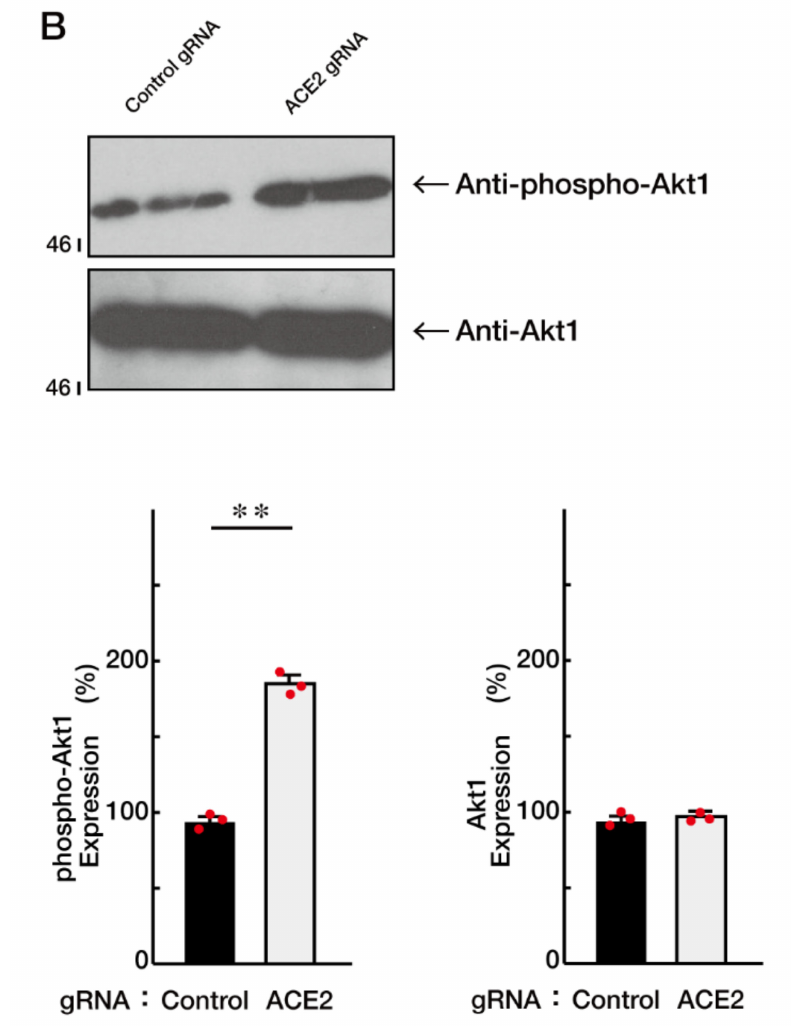
Figure 3. Knockdown of ACE2 promotes Akt1 phosphorylation whose site is essential for Akt1 activation. ( A ) The lysates of siRNA-knocked down FBD-102b cells were used for immunoblotting with an anti-phosphorylated (phospho) Akt1 or Akt1. These two different blots were performed from the same samples. Band intensities were also compared to be depicted in graphs (**, p < 0.01; n = 3 blots). ( B ) The lysates of gRNA-knocked down cells were used for immunoblotting with an anti-phosphorylated (phospho) Akt1 or Akt1. These two different blots were performed from the same samples. Band intensities were also compared to be depicted in graphs (**, p < 0.01; n = 3